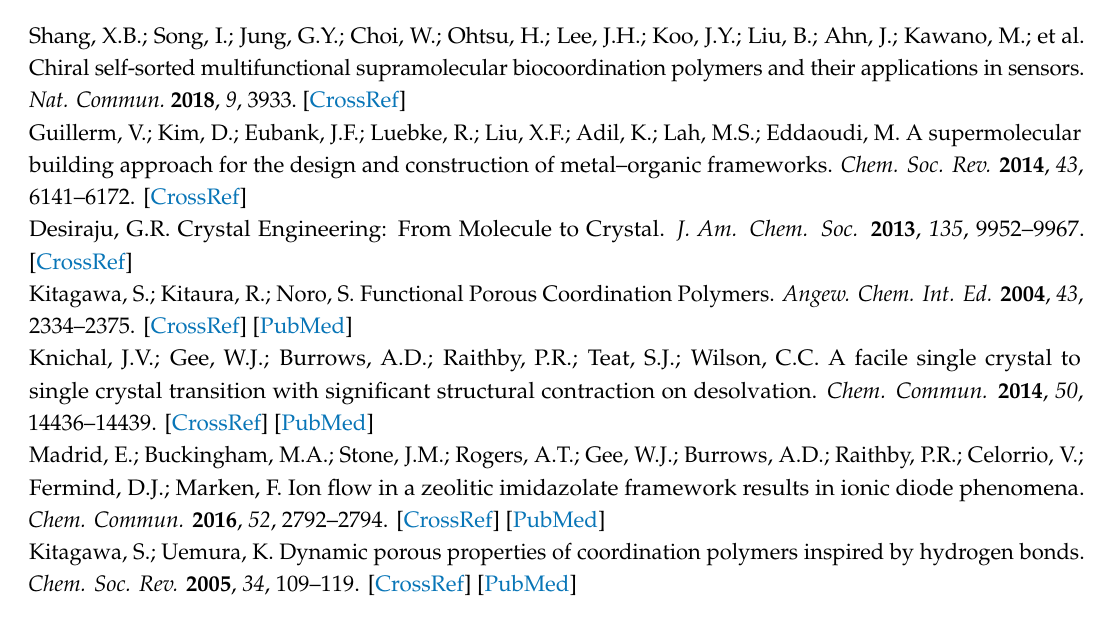
Figure S1. The simulated and experimental PXRD of Polymer 1; Figure S2. The simulated and experimental PXRD of Polymer 2; Figure S3. The simulated and experimental PXRD of Polymer 3; Figure S4. TGA curves for the three polymers; Table S1. Hydrogen-bond geometry (Å, ◦ ) of the three